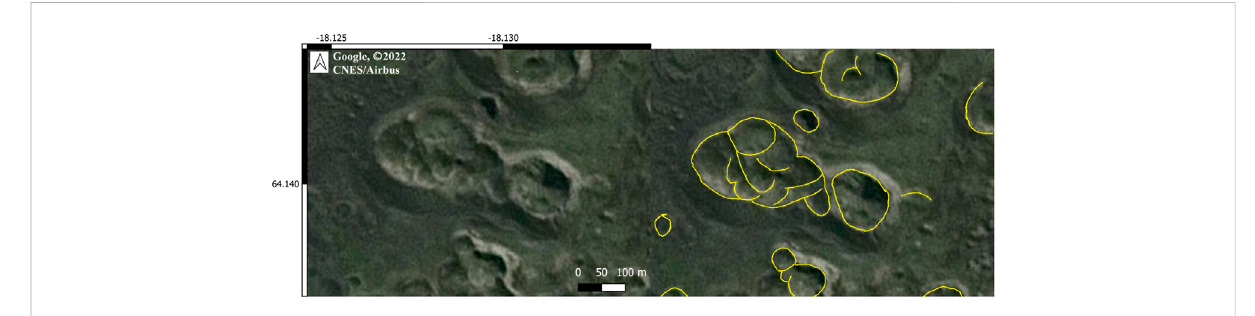
FIGURE 10 Spatter landforms (Laki, Iceland in this example) can be comprised of multiple layers of overlapping semi, half, and full